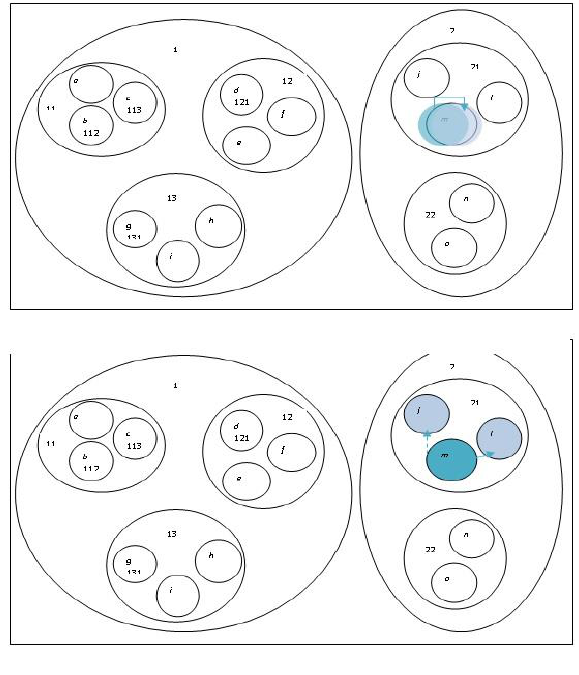
Figure. 5 to Figure. 6 illustrates the working of